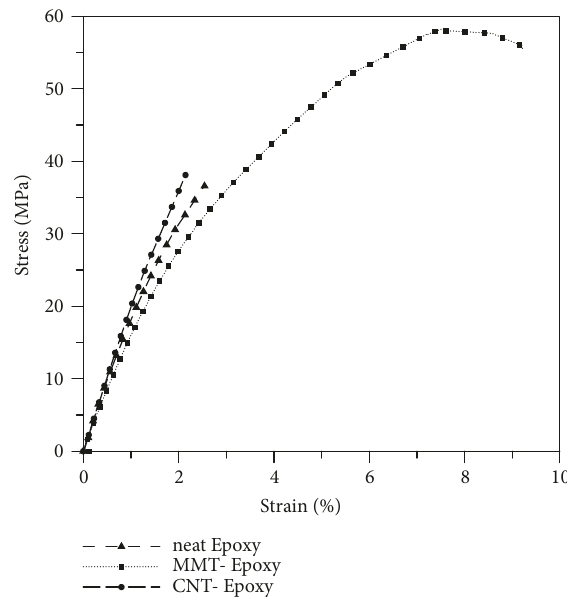
Figure 8: Stress strain graphs of neat epoxy and MMT/SWCNT- epoxy in optimum fraction, conducted at 0.5mm.min - 1 of cross head